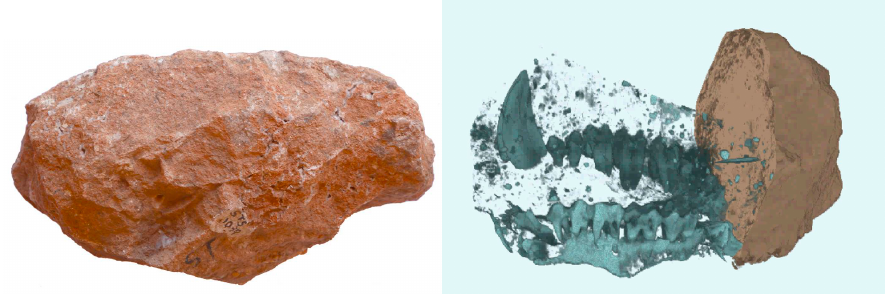
Figure 3. ( a ) Photo of the Breccia rock, left ( b ) Neutron computed tomography of the rock, right (photo by FRM II and original image).